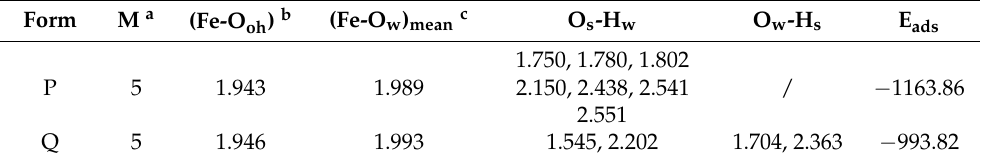
Figure 5. The outer layer adsorption structures of hydrated Fe(OH) 2+ on Si-O surface (P) and Al-OH surface (Q), respectively. Table 3. Bond length (Å) and adsorption energies (KJ/mol) of Fe(OH)(H 2 O) 52+